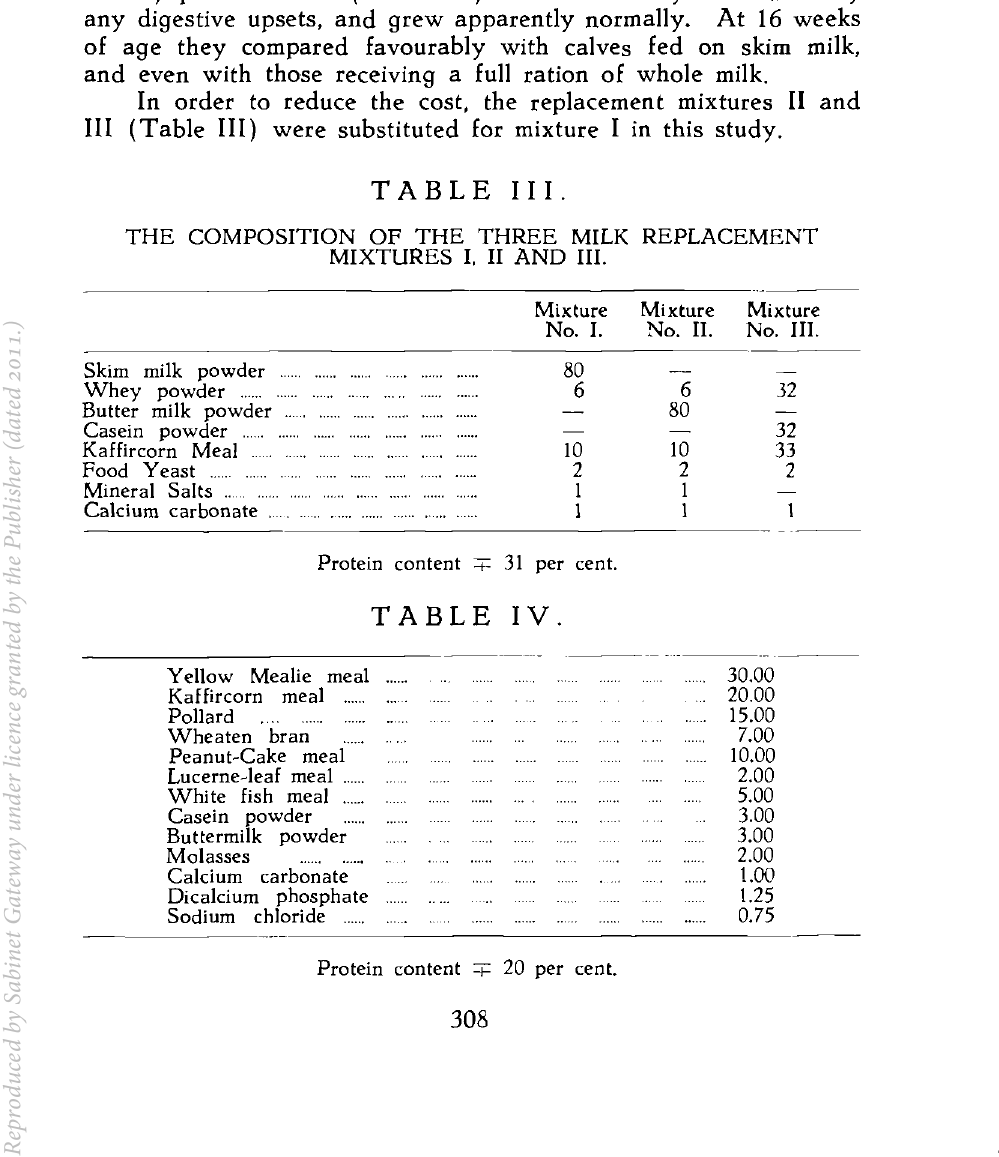
THE COMPOSITION OF THE THREE MILK REPLACEMENT MIXTURES I. II AND III.